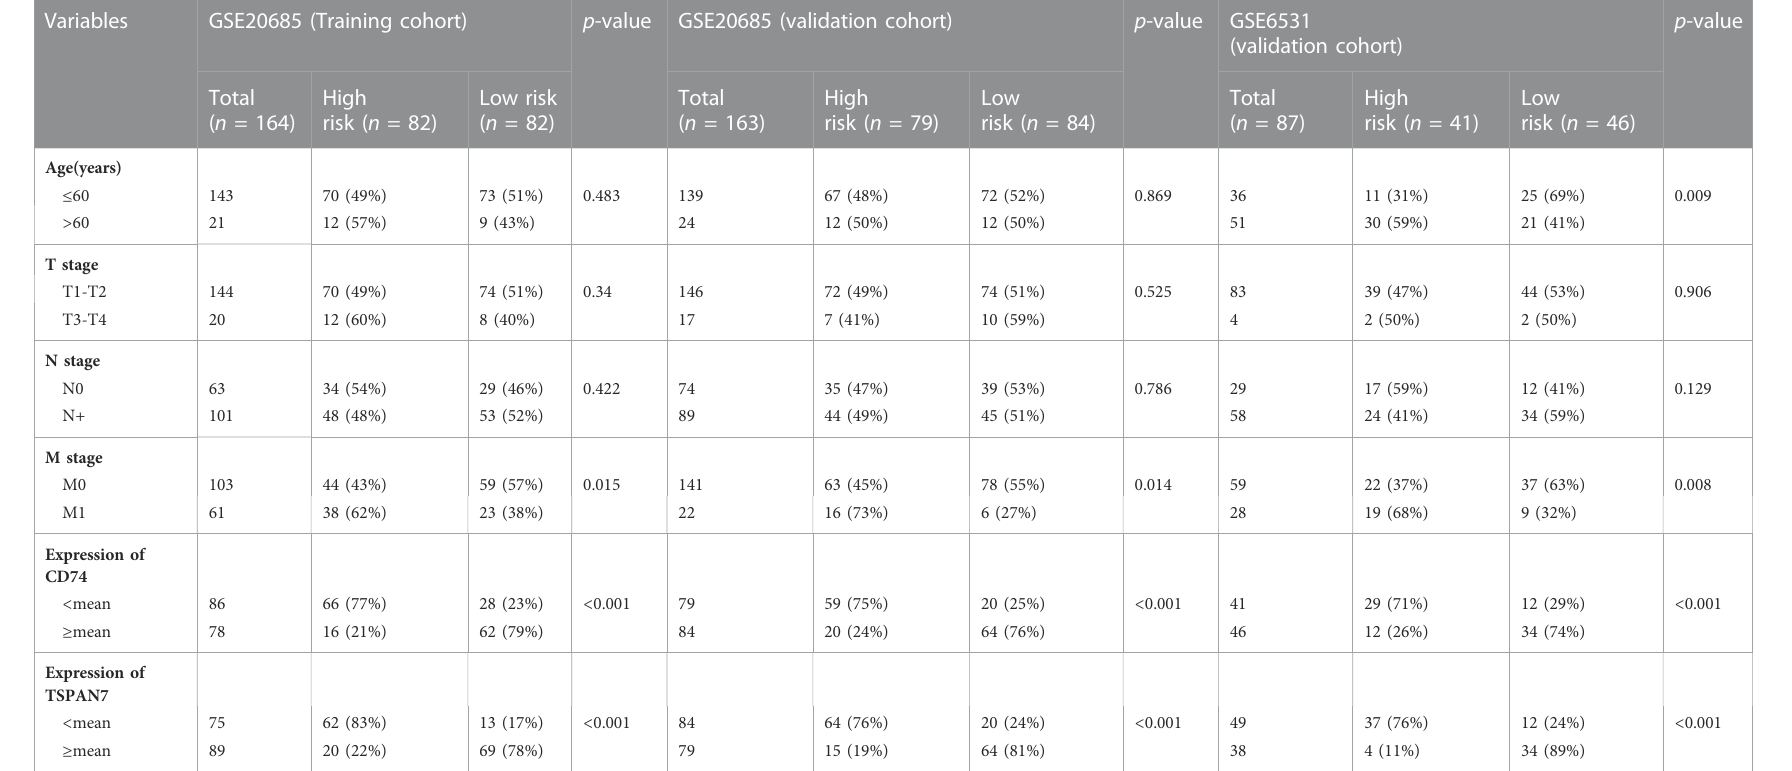
TABLE 1 The relationship between the signature and patient characteristics.